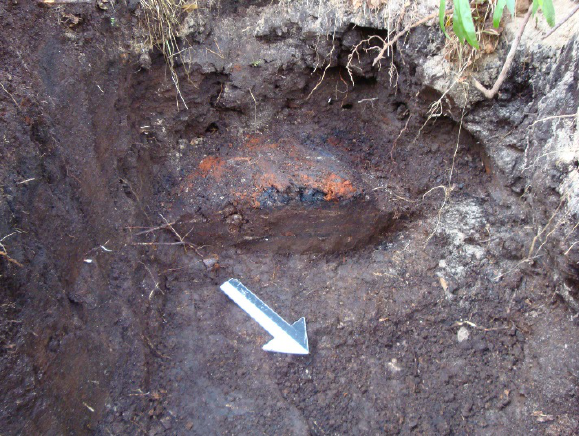
Figure 8. Tree trunk with one side charred and hollowed-out, found in Żyglin peat (photo courtesy of M. Michnik and R. Zdaniewicz). This trunk was radiocarbon dated to 3580 ± 40 14 C yr BP, and the calibrated radiocarbon age is 1885– 1980 BC (using IntCal13 calibration